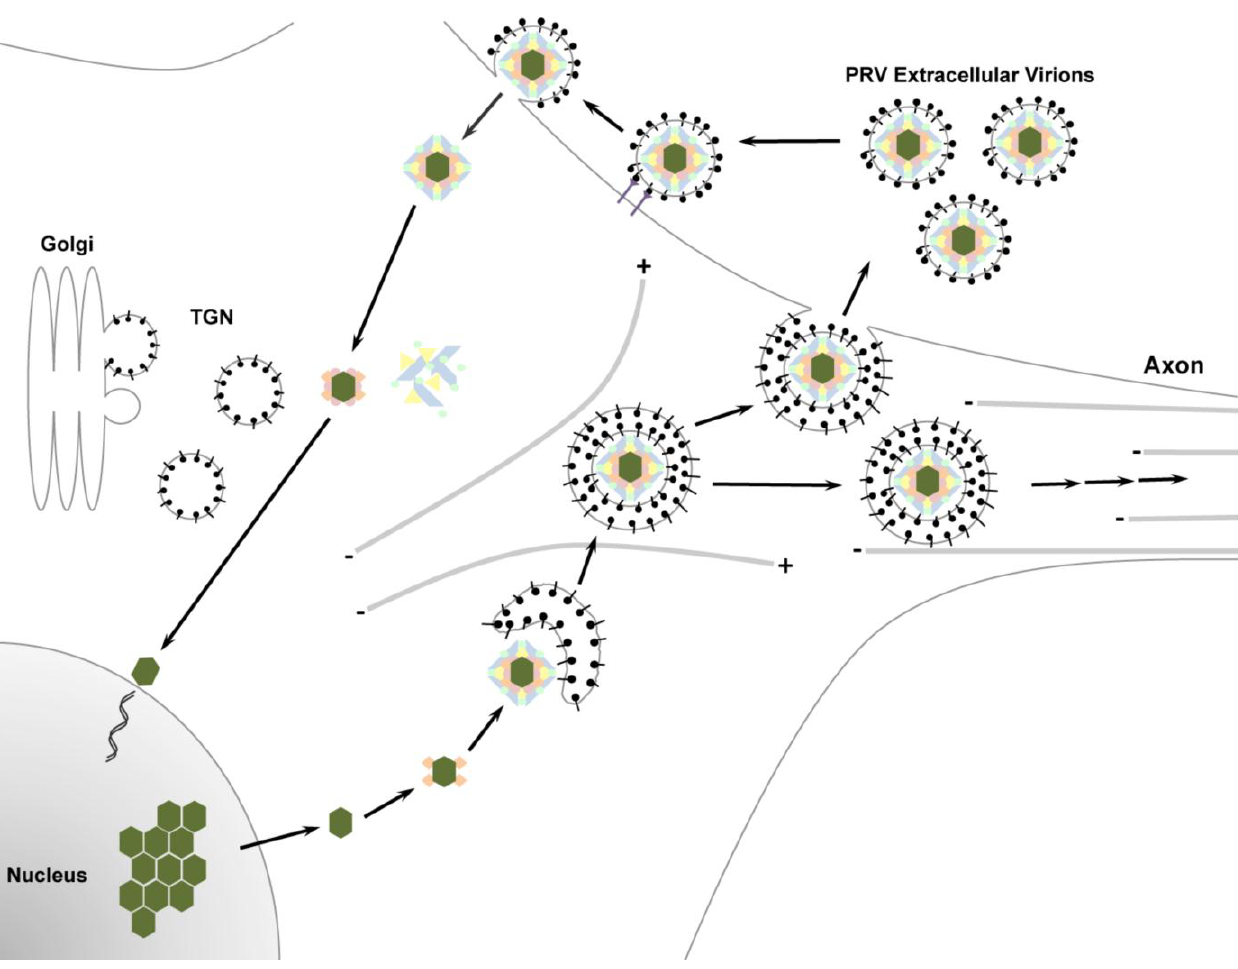
Figure 2. The pseudorabies virus (PRV) replication cycle. Following virion attachment and entry, viral capsids and tegument proteins are released into the cytoplasm. Many of the tegument proteins previously contained within the virion are released into the cytoplasm. Viral capsids and a specific subset of tegument proteins are trafficked towards the nucleus, where the viral genome is deposited and replicated. Capsids containing newly replicated viral genomes are released from the nucleus into the cytoplasm, where they further mature by acquiring viral and host tegument proteins. Final maturation occurs by envelopment of viral particles into vesicles derived from the trans-Golgi network (TGN) that contain viral and host membrane proteins. This process, known as secondary envelopment, results in a mature virion that is contained within a transport vesicle. Enveloped virions are trafficked towards sites of egress along the cell surface. In neurons, enveloped virions are sorted into axons and transported long distances along microtubules towards distal egress sites. At the target membrane, the transport vesicle and plasma membrane fuse, releasing a mature, enveloped PRV virion from the